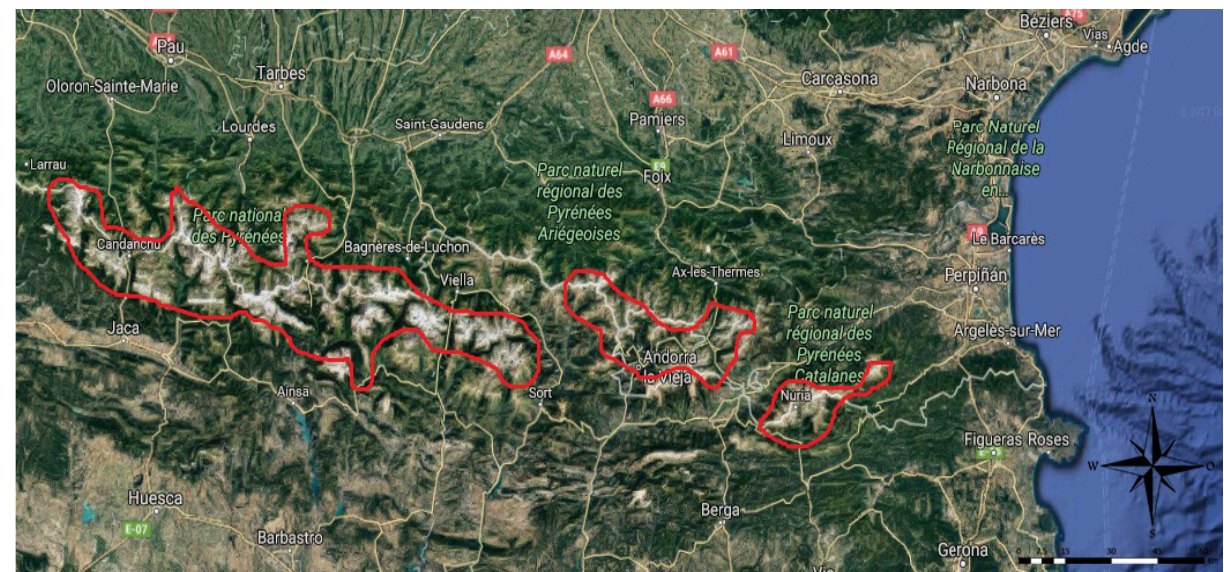
Figure 2. Delimitation of the alpine or supraforest or Crioro-Mediterranean life